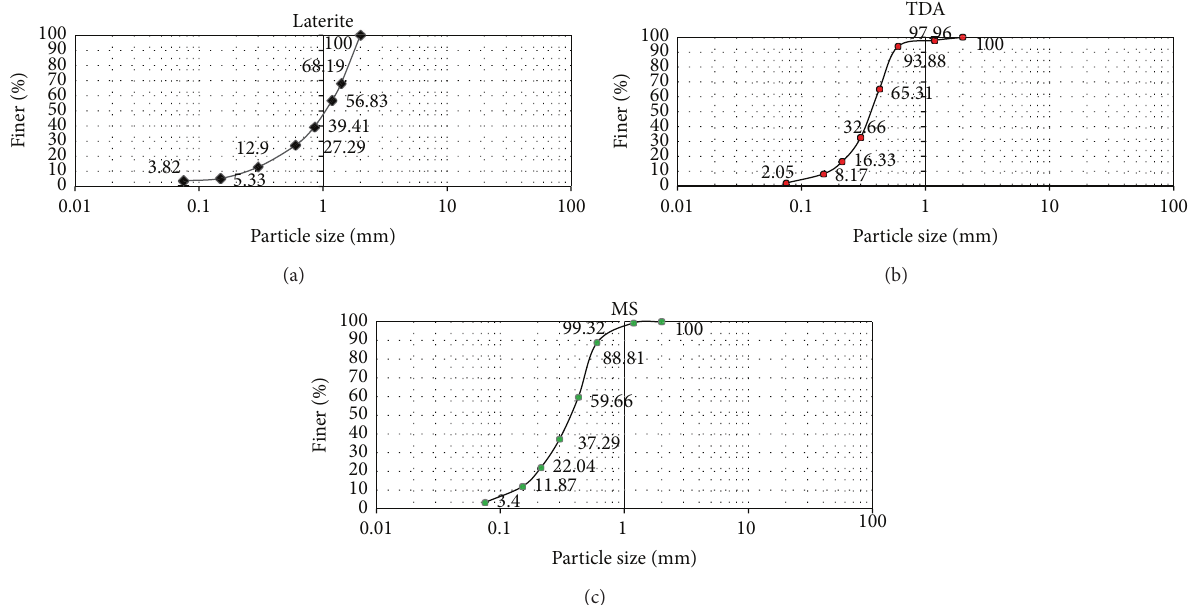
Figure 1: Distribution of gradation for different materials. (a) Laterite, (b) tire driven aggregate, and (c) microsilica.